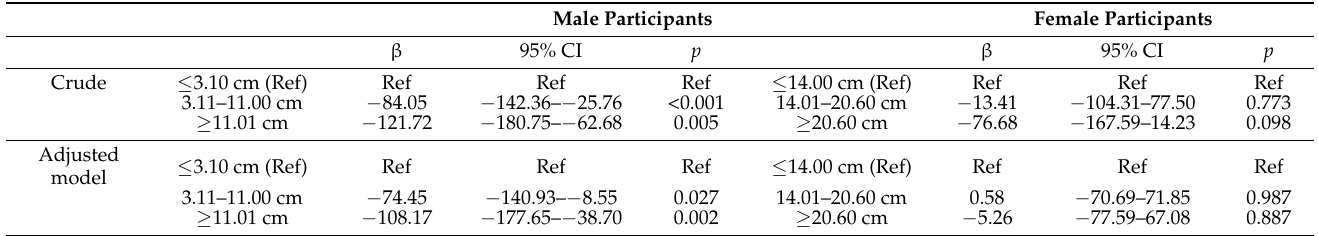
Table 3. Association between the sit-and-reach test result and brachial–ankle pulse wave velocity. Male